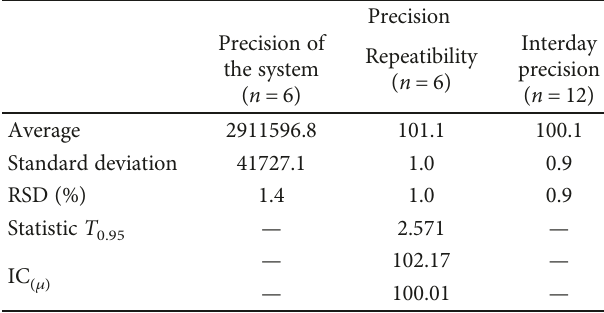
Table 3: Precision results for ketorolac and its degradation products.